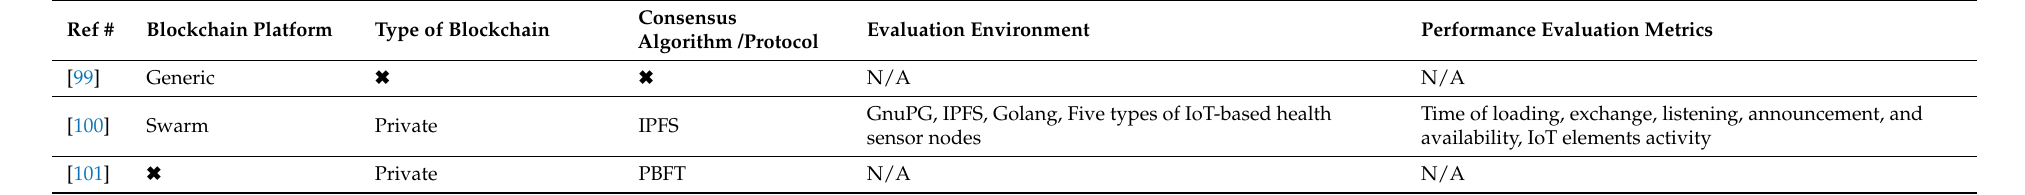
Table 4. Healthcare Articles: Blockchain Characteristics, Evaluation Environment, and